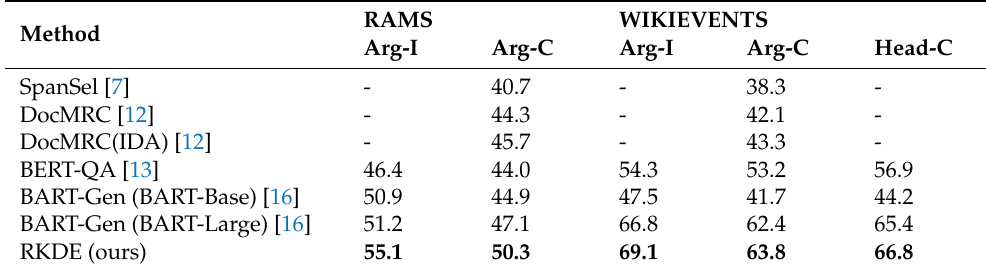
Table 2. Main results on RAMS and WIKIEVENTS datasets (F1 score